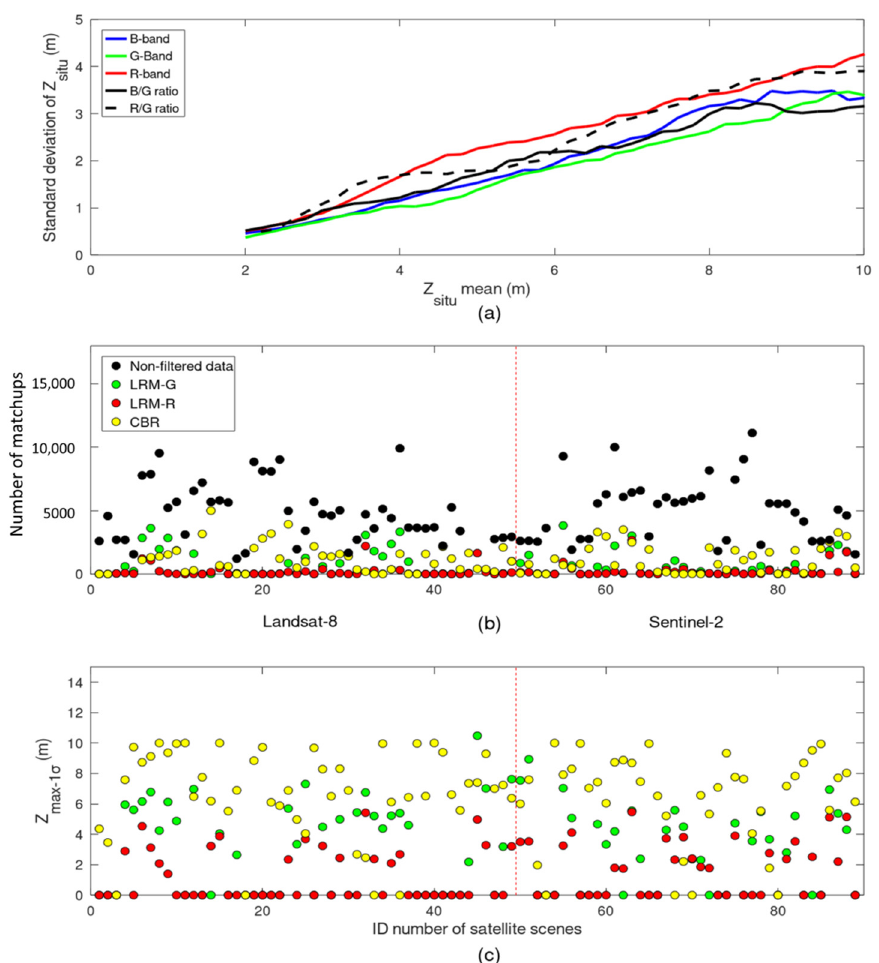
Figure 6. ( a ) Evolution of the standard deviation of Z situ as a function of Z situ mean computed over the 89 Landsat-8 and Sentinel-2 images for the different parameterizations of log-transformed bands and ratios; ( b ) number of matchups available for each of the 89 satellite images for non-filtered data and for 1 σ -filtered data using LRM-G, LRM-R, and CBR approaches; ( c ) computation of the 1 σ -filter maximum bathymetry for each of the 89 satellite images.